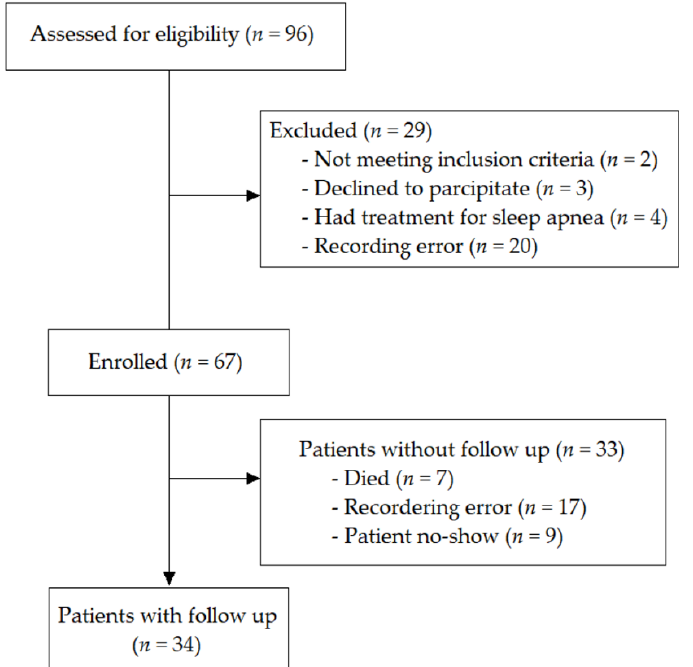
Figure 1. Consort flow chart showing how the analytical sample was derived from the participants who were assessed for eligibility. who were assessed for